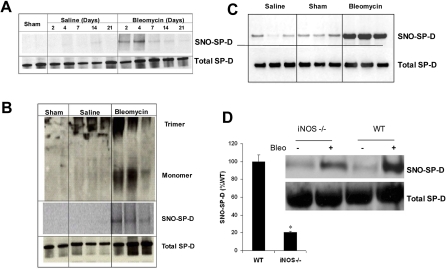
Acute Lung Injury in the Rodent Produces Results in SNO-SP-D Formation and Multimer Disruption(A) Untreated (control), saline, or bleomycin was intratracheally administered to Sprague-Dawley rats. BAL was collected at days 2, 4, 7, 14, and 21 after injection. BAL (upper) was subjected to biotin-switch assay to detect SNO-SP-D. (Lower) Total SP-D in BAL was identified by immunoblot.(B) Untreated (control), saline, or bleomycin was intratracheally injected at a dose of 8 U/kg in Sprague-Dawley rats. BAL was collected at day 4 after injection. BAL (upper) was subjected to electrophoresis for native gel to detect different fragments of SP-D. BAL (middle) was subjected to biotin-switch assay to detect SNO-SP-D. (Lower) Total SP-D in BAL was identified by immunoblot.(C) Untreated (control), saline, or bleomycin was administered to C57/BL6 mice intratracheally at a dose of 3 U/kg. BAL was collected at day 8 after treatment; total SNO content within the BAL was 0.2 ± 0.22 μM in control mice and 2.1 ± 0.88 μM in bleomycin treated. SNO-SP-D content was assessed by the biotin switch method.(D) SNO-SP-D in the BAL of bleomycin-treated wild type versus bleomycin-treated iNOS
–/– mice (8-d post-injury) was measured by biotin-switch assay; Total input of SP-D was same between groups. (asterisk represents significantly different from wild type; p < 0.05). Representative blots show SNO-SP-D and total SP-D. Data are mean ± SEM.